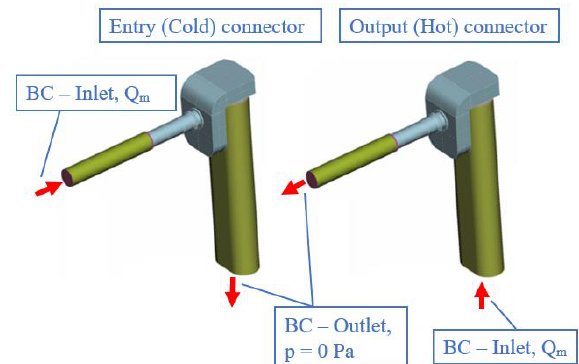
Fig. 5. Contours of Velocity Magnitude v /